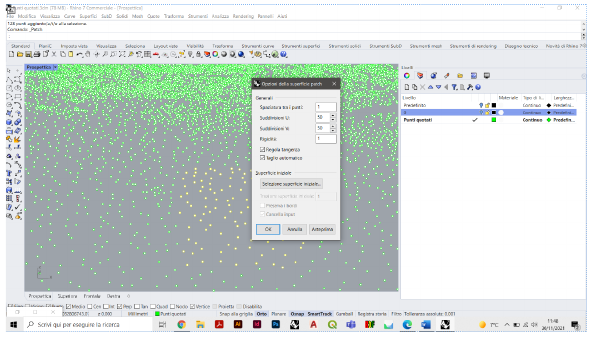
Figure 2 . Patch command before UV subdivision.